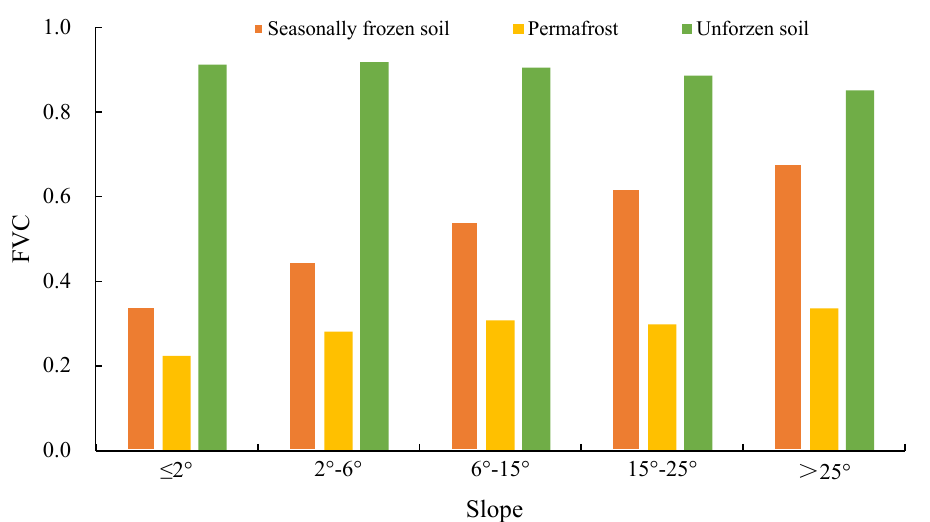
Figure 8. Variation of FVC at different slopes for different types of soil on the Qinghai–Tibet Plateau.